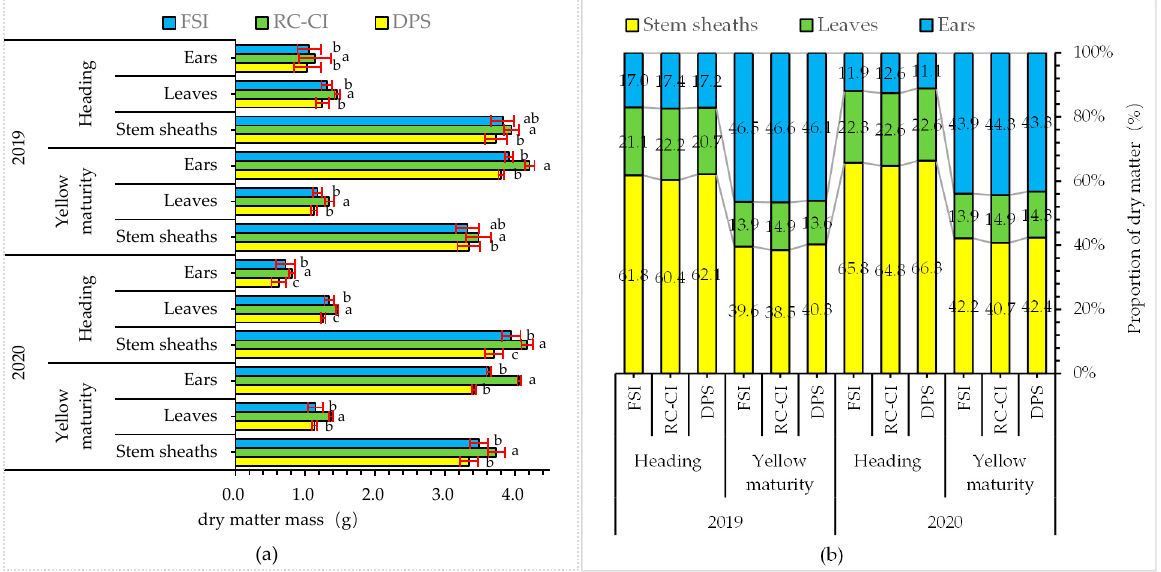
Figure 2. Quality and ratio of dry matter in the upper part of rice in different irrigation and drainage modes: ( a ) Quality of dry matter in the upper part of rice in different irrigation and drainage modes in heading period and yellow maturity period in two years. The different letters on the right of columns indicate significant differences among treatments at 5% according to Duncan’s multiple range test; ( b ) Ratio of dry matter in the upper part of rice in different modes in heading period and yellow maturity period in two years.